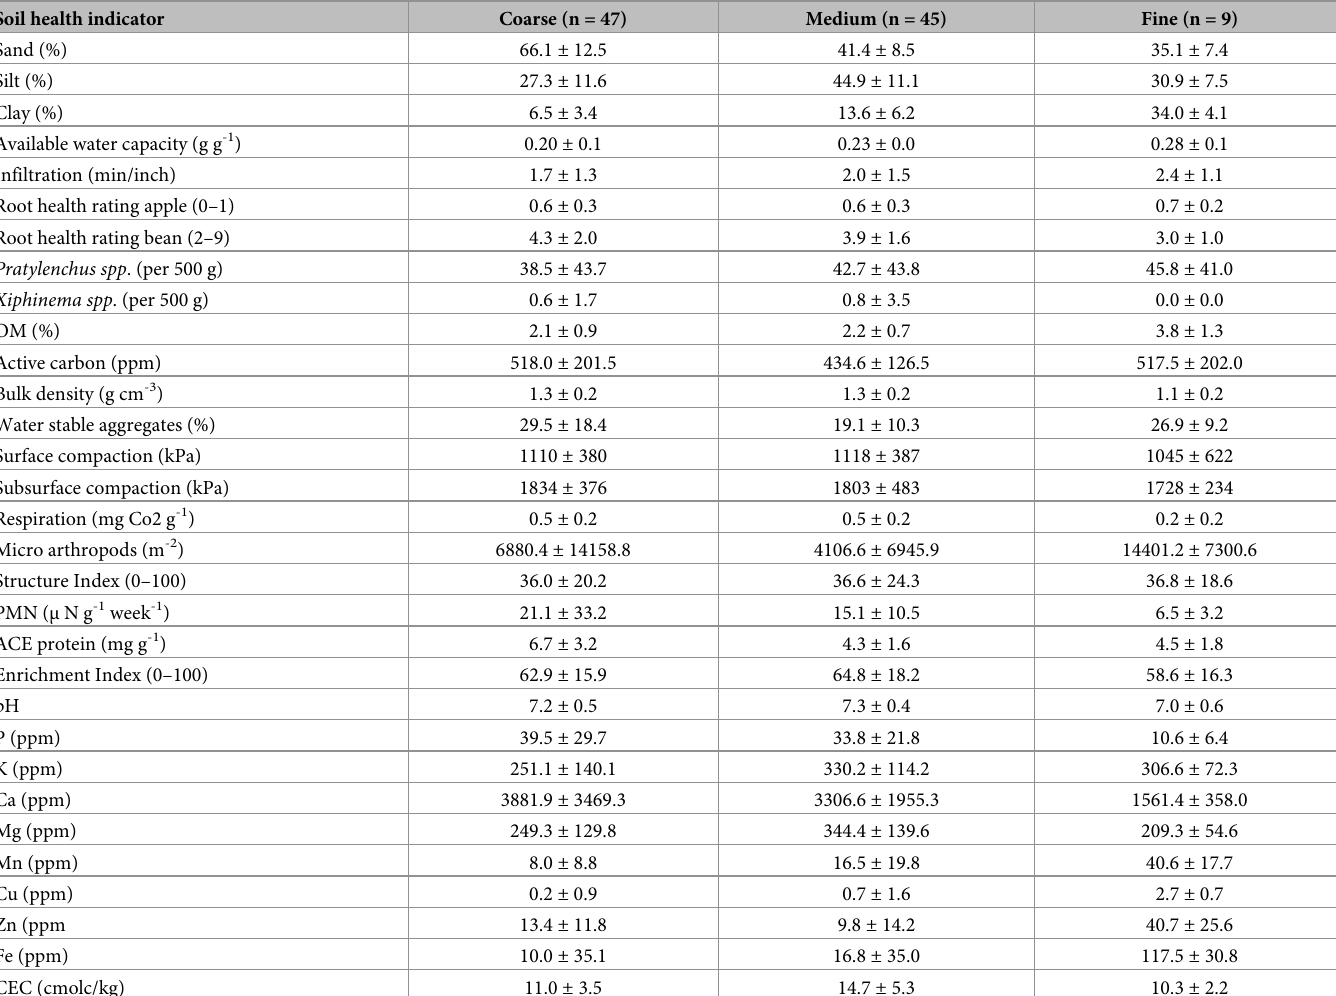
Table 1. Mean ( ± SD) for textural distribution and soil health indicators by textural group.